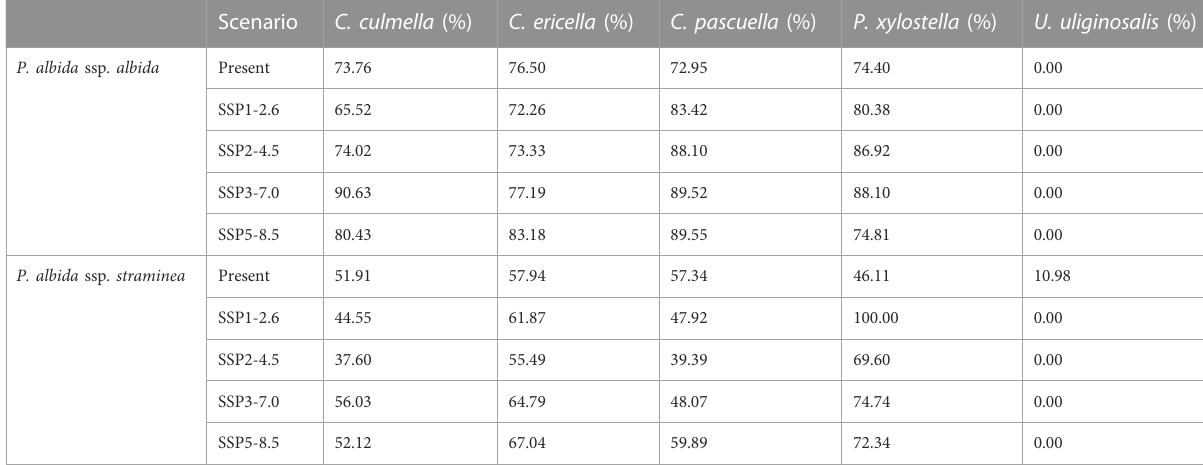
TABLE 4 Overlap of potential ranges of P. albida and its pollinators.